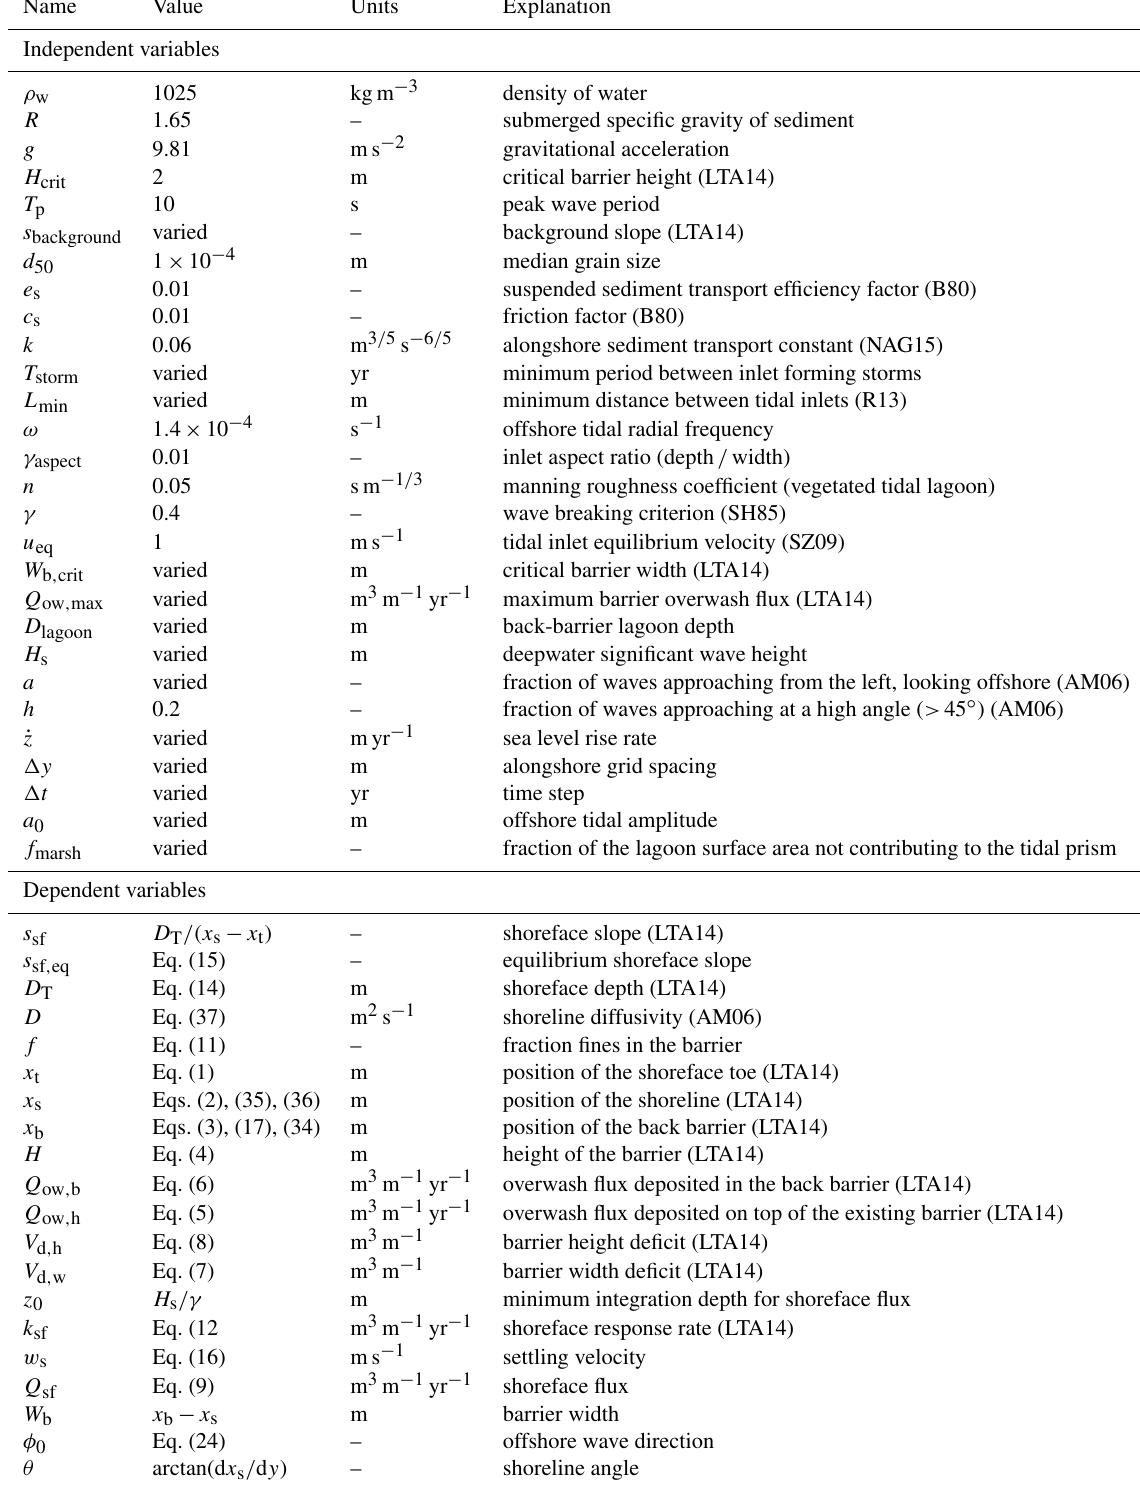
Table 1. Model variables and their dimensions. Shortened references are as follows: LTA14 (Lorenzo-Trueba and Ashton, 2014), B80 (Bowen, 1980), N15 (Nienhuis et al., 2015), R13 (Roos et al., 2013), SH85 (Sallenger and Holman, 1985), SZ09 (de Swart and Zimmerman, 2009), AM06 (Ashton and Murray, 2006), NA16 (Nienhuis and Ashton,